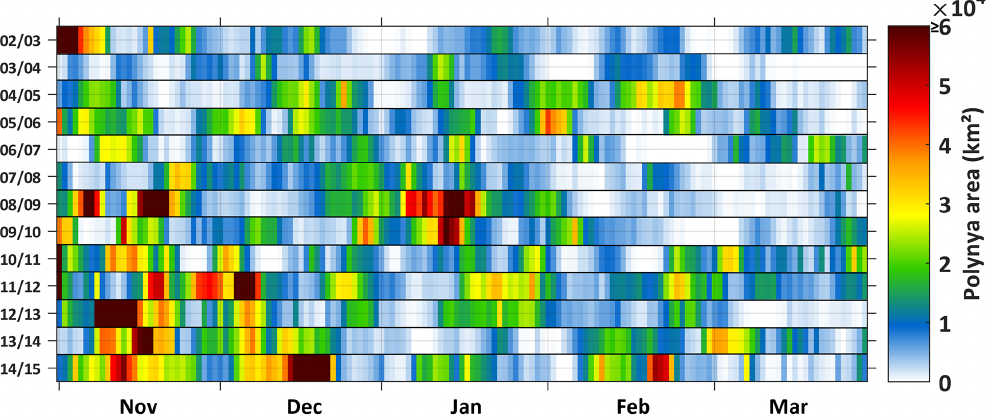
Figure 10. The daily polynya area (TIT ≤ 0.2m) in the Laptev Sea region for the winter seasons 2002/2003 to 2014/2015. Values are calculated within the margins of the applied polynya mask (Fig. 1) and saturated at a level of 6 × 10 4 km 2 for a better discrimination of lower